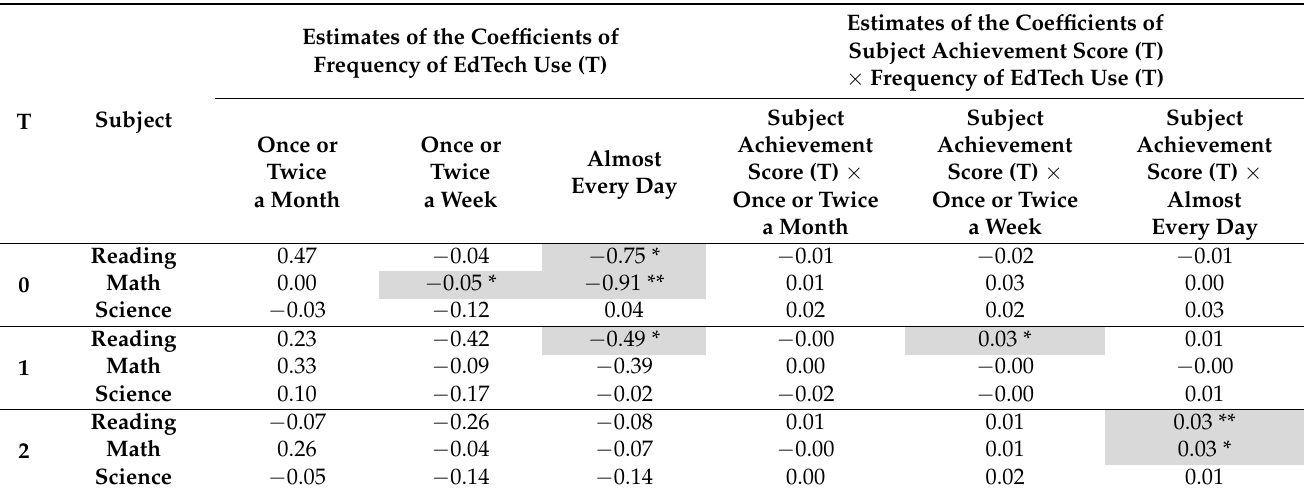
Table 5. Estimates of the coefficients of frequency of EdTech use (T) and subject achievement score (T) × frequency of EdTech use (T) in Model